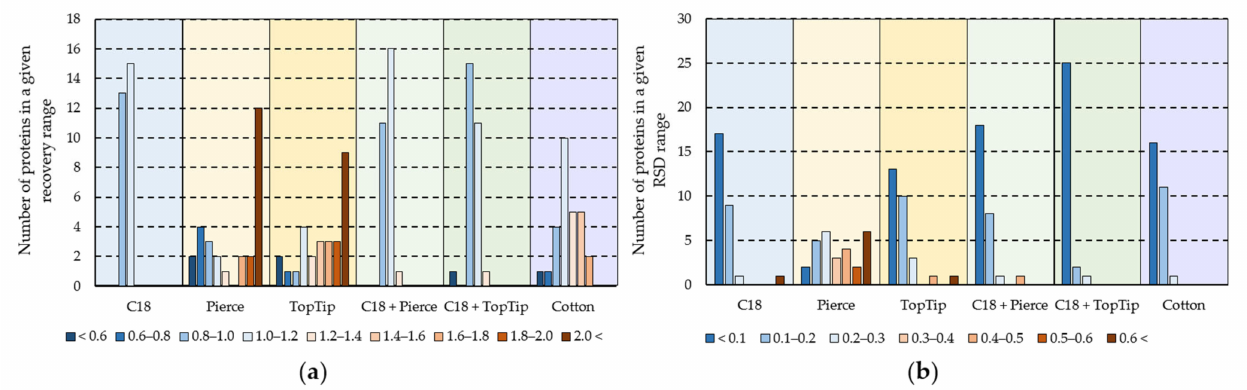
Figure 4. ( a ) Protein recovery value distributions relative to the reference method; ( b ) Protein LFQ intensity RSD value distributions for the six SPE